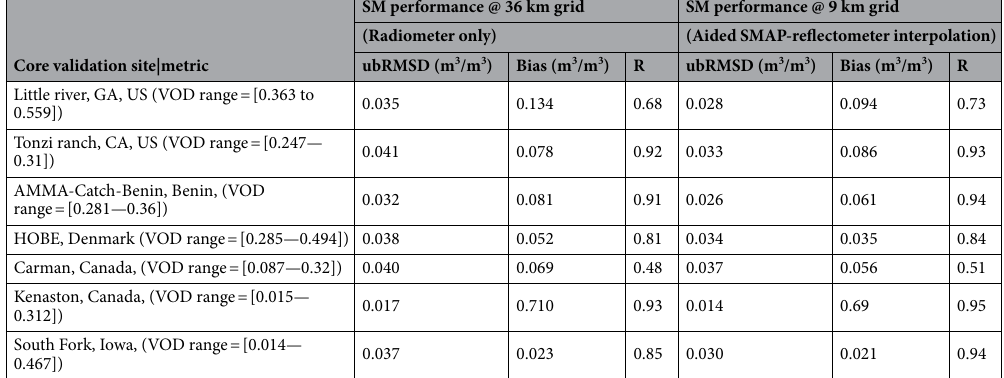
Core validation